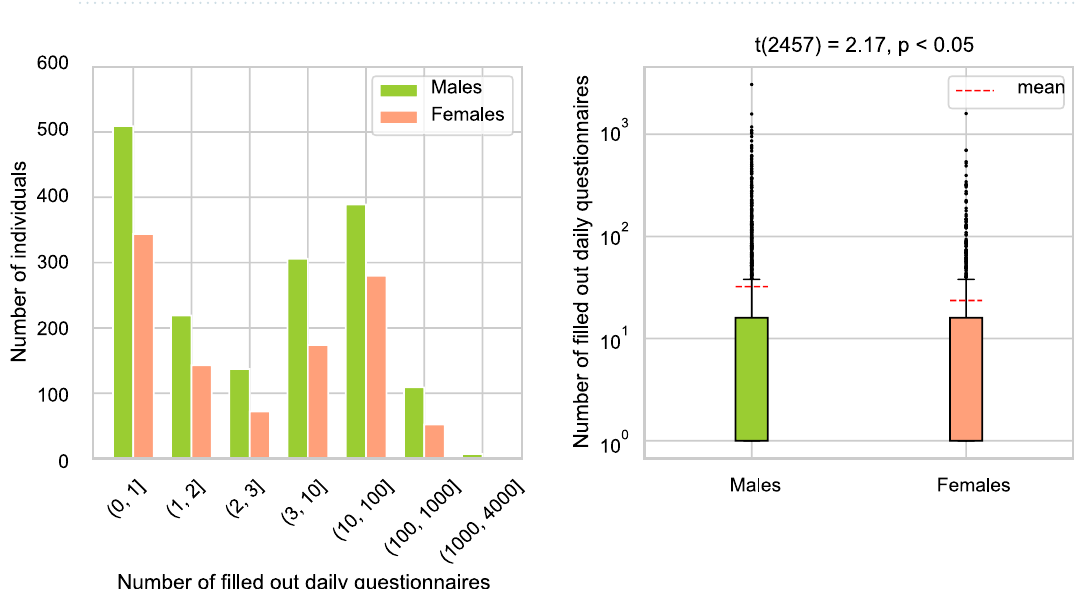
Figure 4. Distribution of the worst symptom grouped by gender in a horizontal stacked plot. Each row of the figure adds up to 100%.